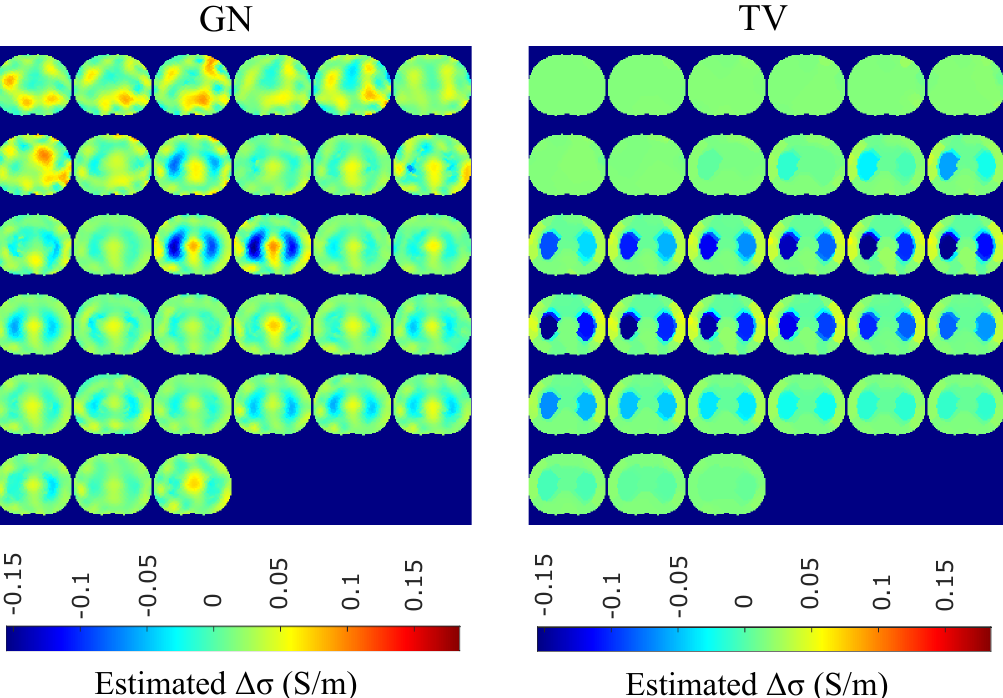
Figure 15. Single–breath in vivo results using the GN and TV approaches.